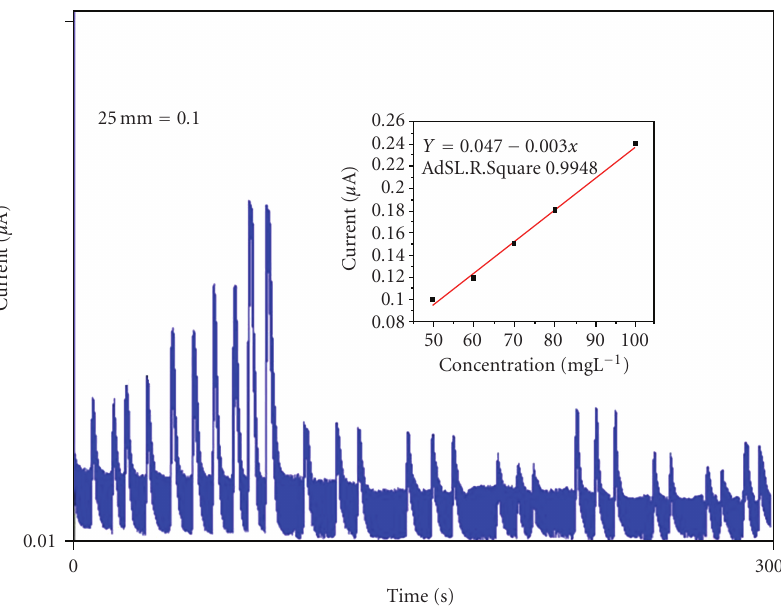
Figure 5: Recorder output of a routine run. From left to right, measurements in duplicate for gallic acid standard solution (50, 60, 70, 80, and 100 mg · L − 1 ) followed by signal of phenolic compounds EGCG (50mg · L − 1 ), EC (50mg · L − 1 ), GA (25 and 50mg · L − 1 ), and di ff erent samples of tea.